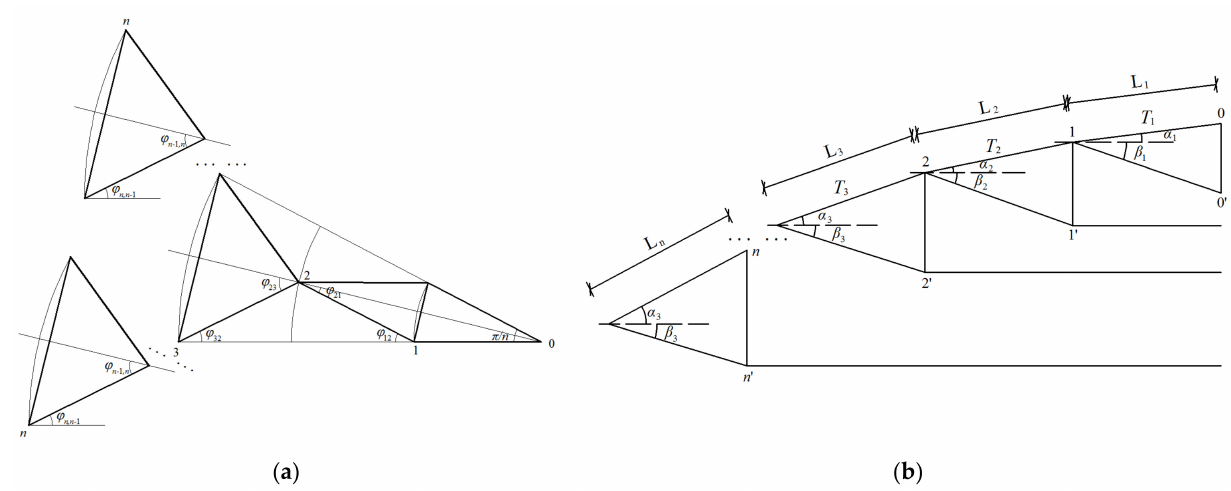
Figure 3. Calculation graphs for the Levy hinged-beam cable dome. ( a ) Plane graph; ( b ) Profile